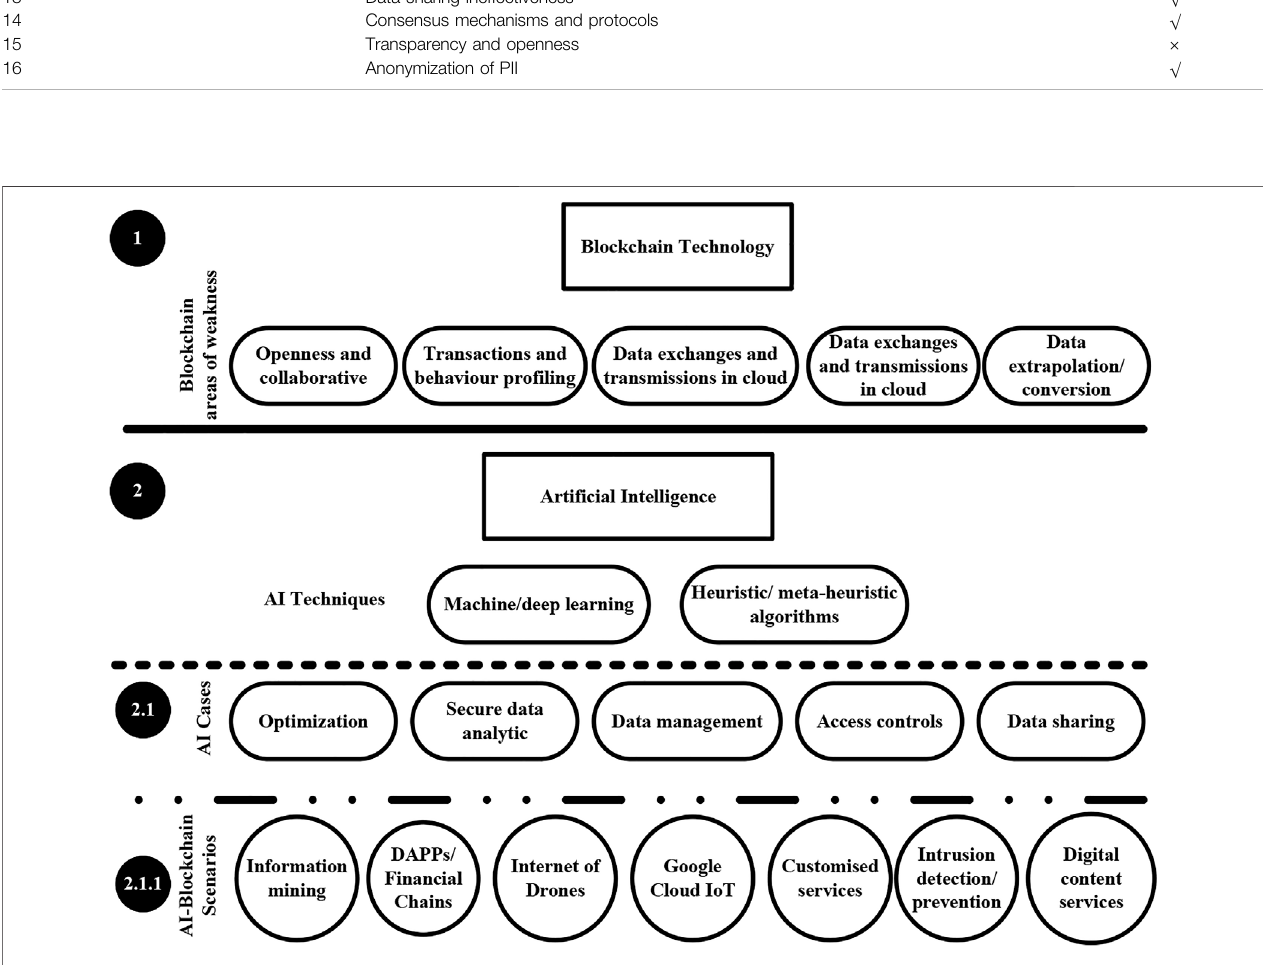
Frontiers in Blockchain |